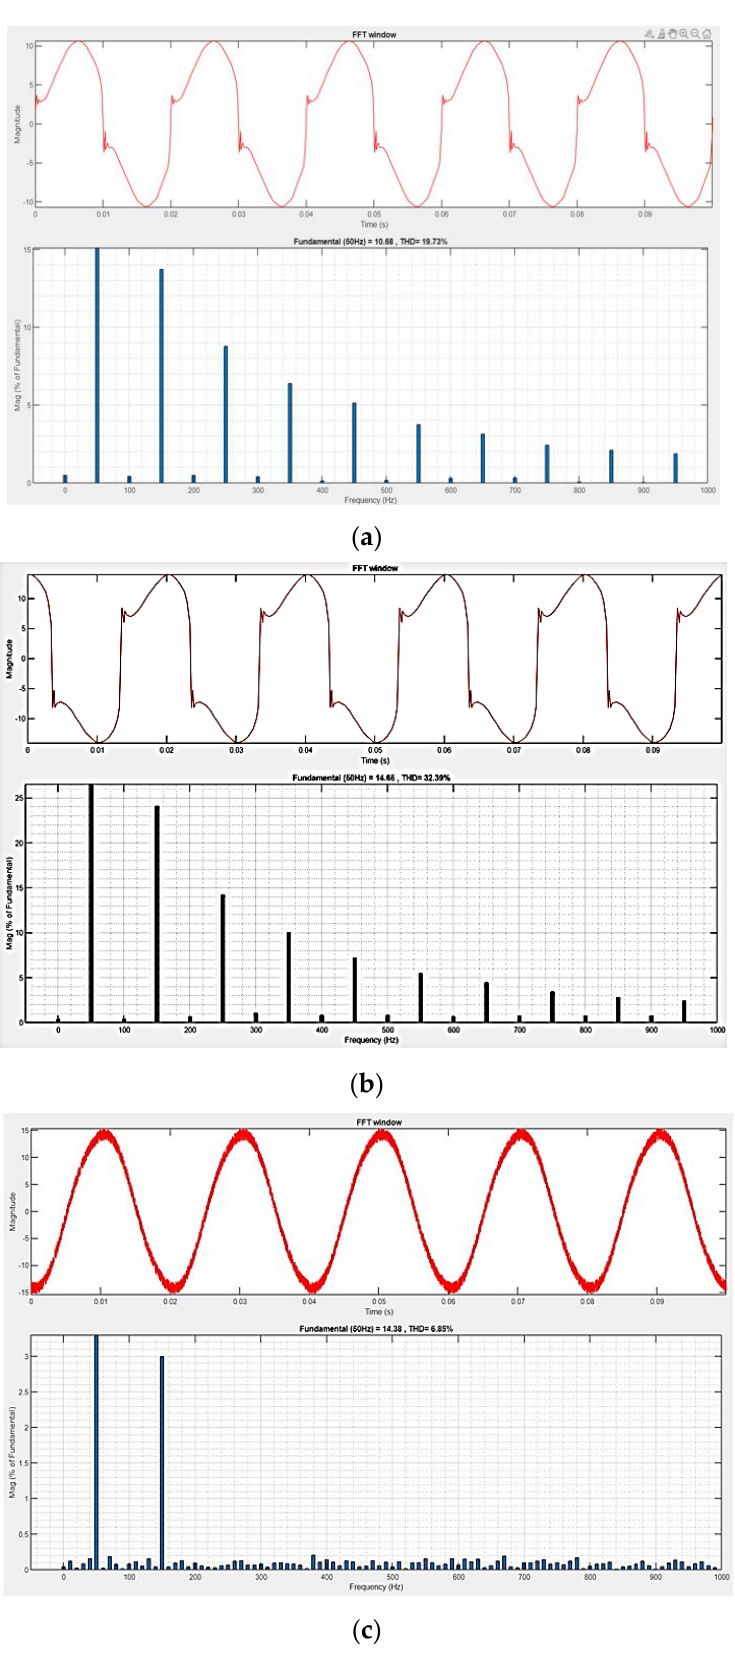
Figure 8. ( a ) THD of A-phase Load current; ( b ) THD of B-phase Load current; ( c ) THD of C-phase Load current.